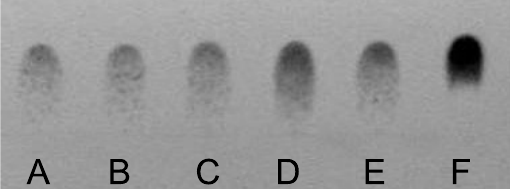
Fig. 1 – TLC plate developed in ninhydrin for glycine analysis. A, B, and C are glycine samples synthesized from 50, 100, and 150 ml ammonia, respectively. Sample D refers to 15 N-enriched glycine. E and F correspond to the glycine p.a.